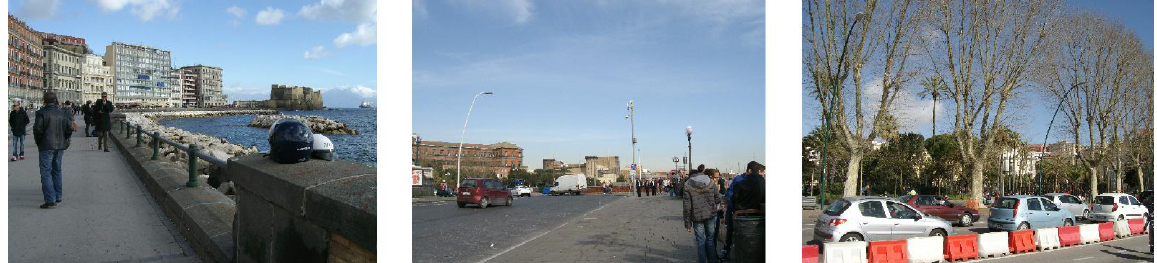
Figure 2: Areas by the sea; from left to right: pedestrian areas (code Sea_PE), limited traflc areas (Sea_LI) and open to road traflc areas (Sea_TR).